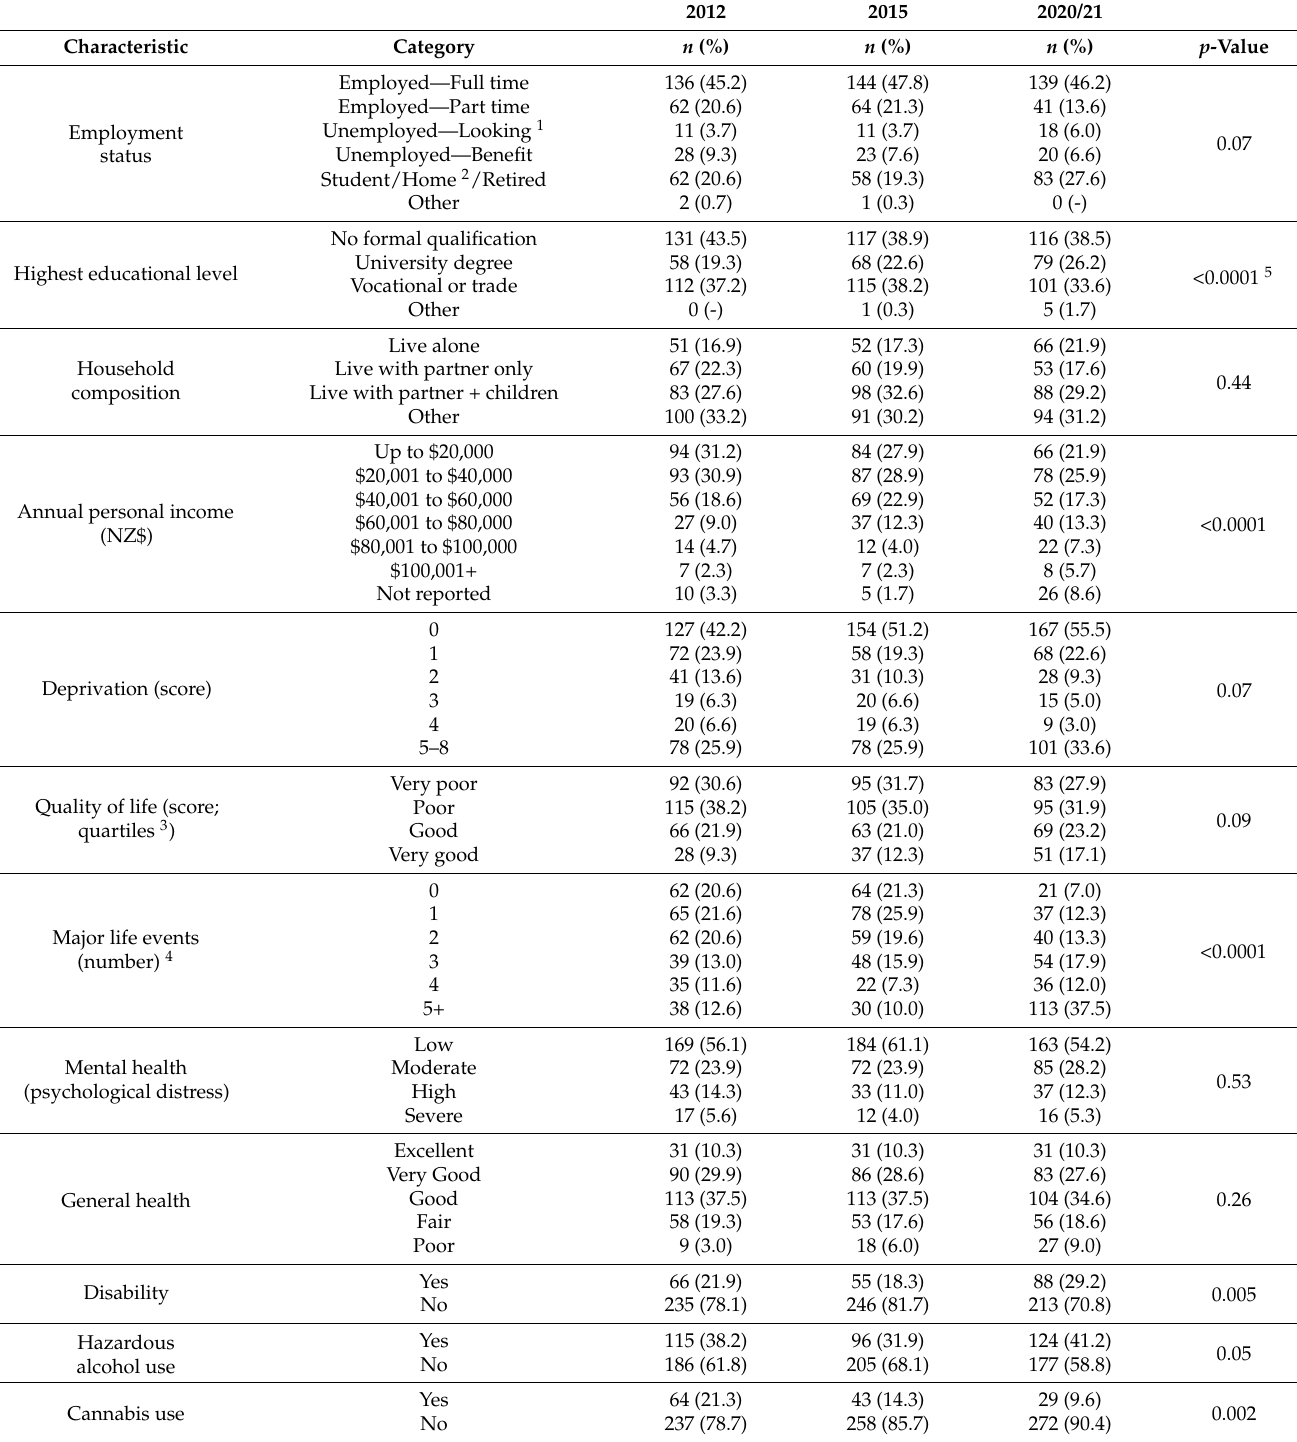
Table 2. Participant sociodemographic characteristics by data collection